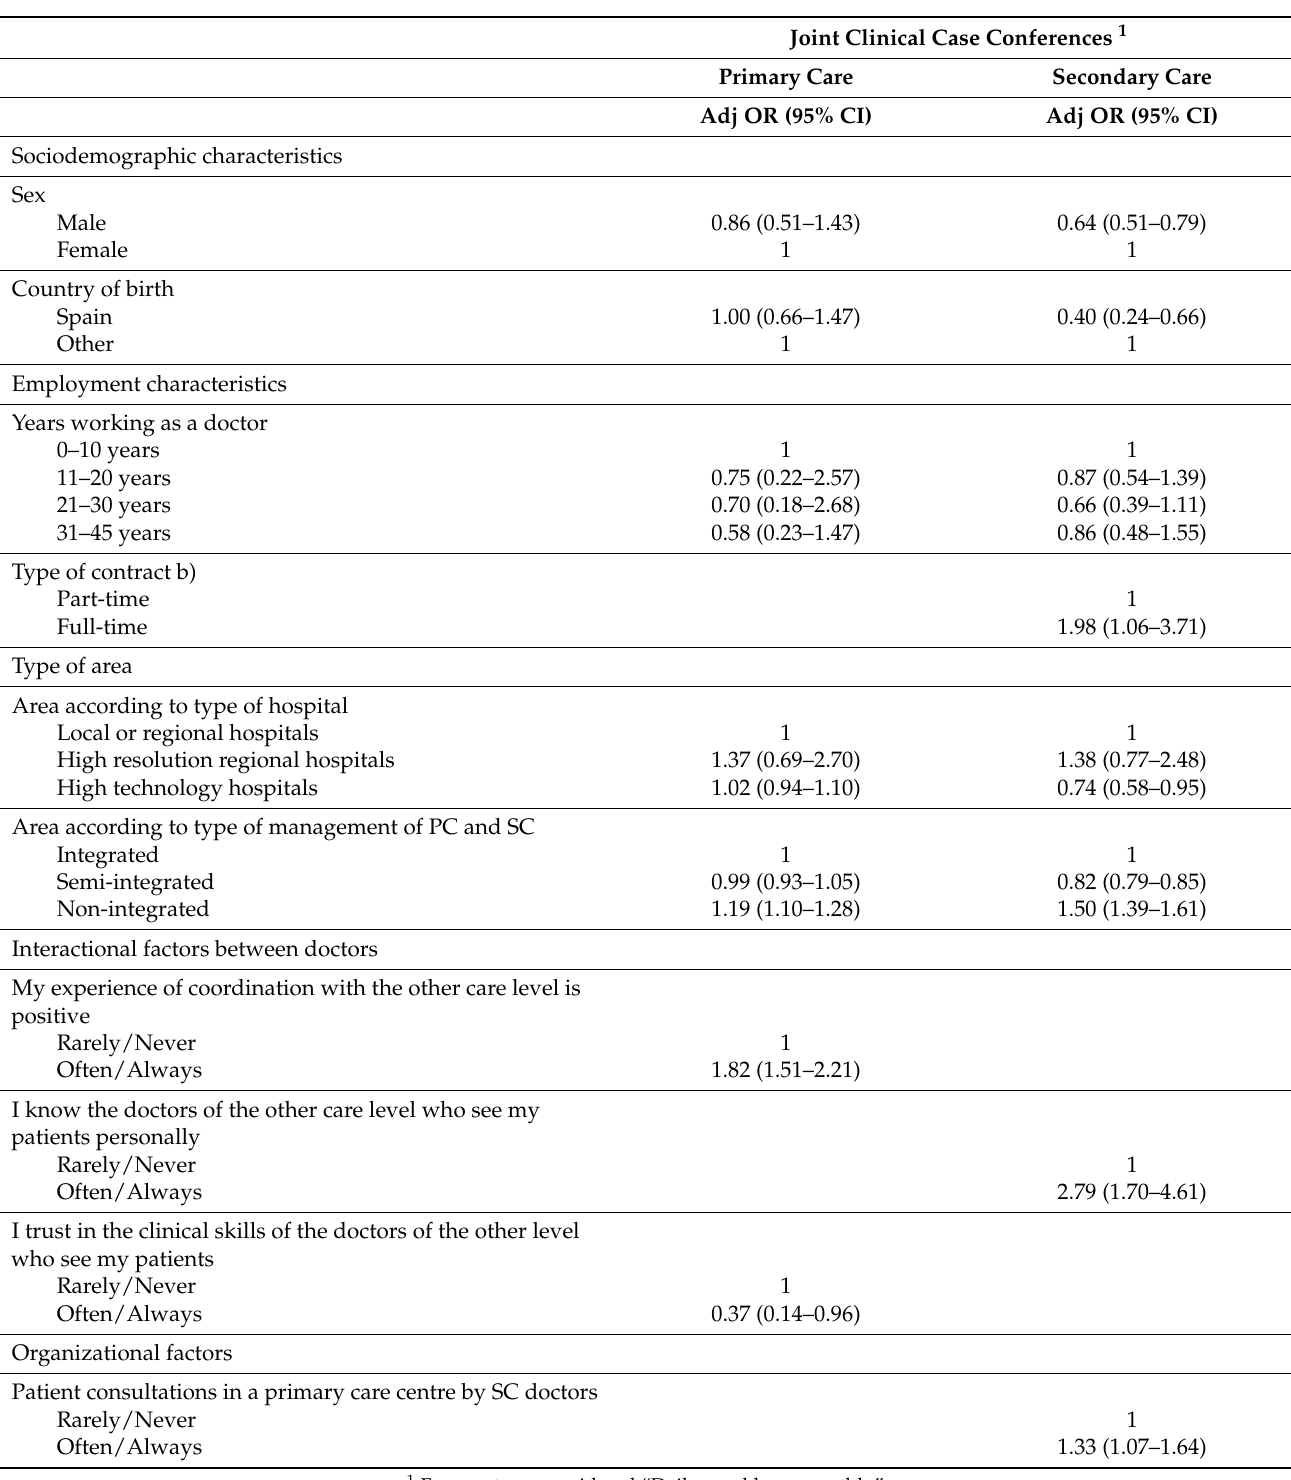
Table 5. Factors associated with frequent participation in joint clinical case conferences, by level of